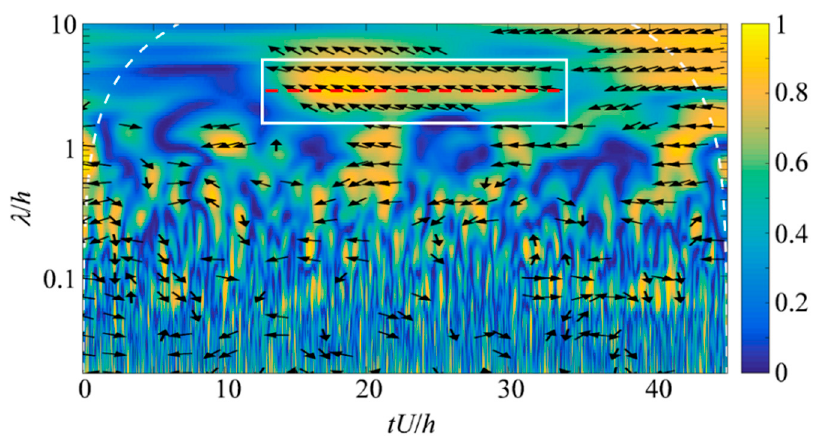
Figure 3. Wavelet coherent coefficients between the streamwise and vertical velocity series at the measurement point ( x / h = 0, y / h = 0.5 ). The white box marks the time duration as the same as that in Figure 2, and the red dash line indicates the 3 h scale. The high coherent area appears in the white box and the phase difference is approximately π .